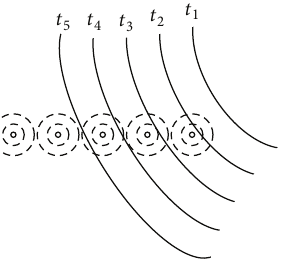
Figure 10: Linearly placed receivers result in even time difference of arrival